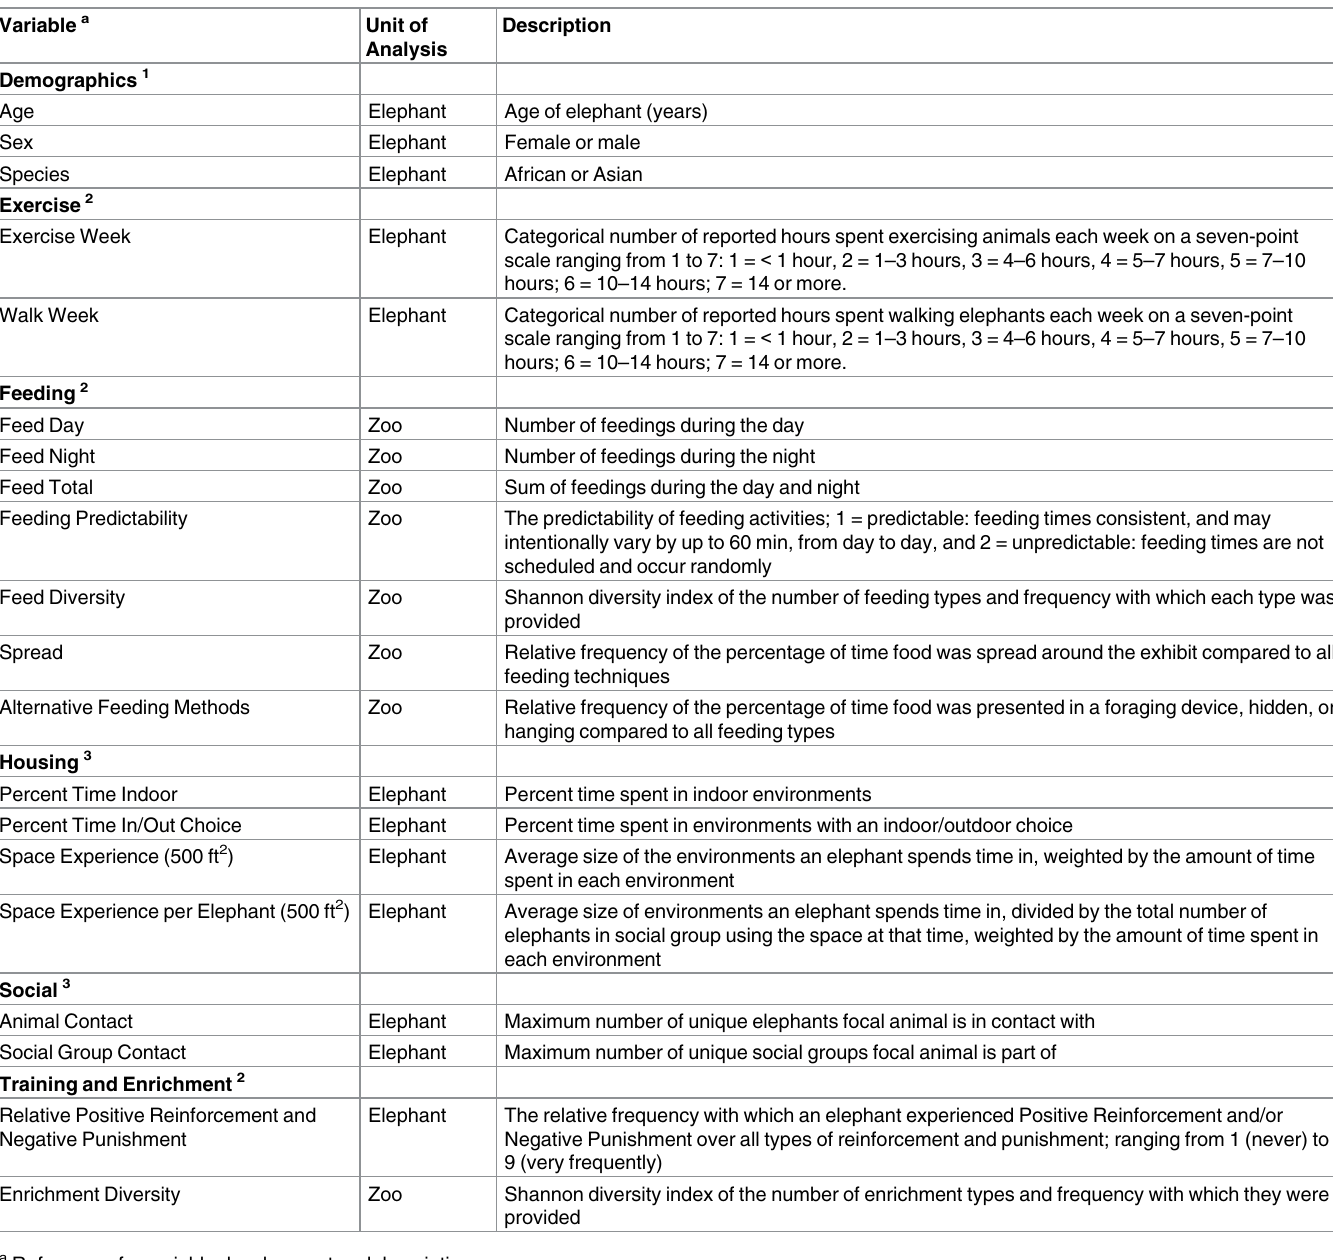
Table 1. Descriptions of variables tested for associations with leptin concentrations and the glucose-to-insulin ratio. Variable